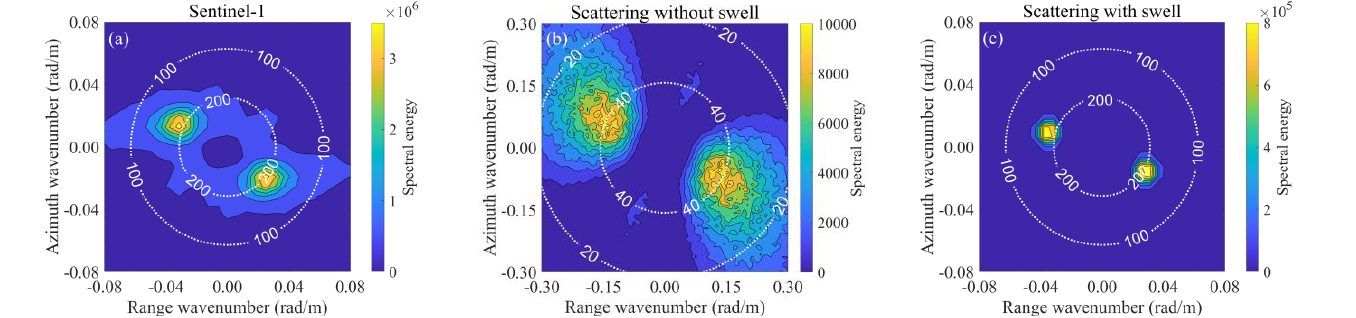
Figure 20. Similar to Figure 18 but corresponding to ID 2. Table 3. The wavelength and direction of dominant wave obtained from the image spectra in Figure 20.